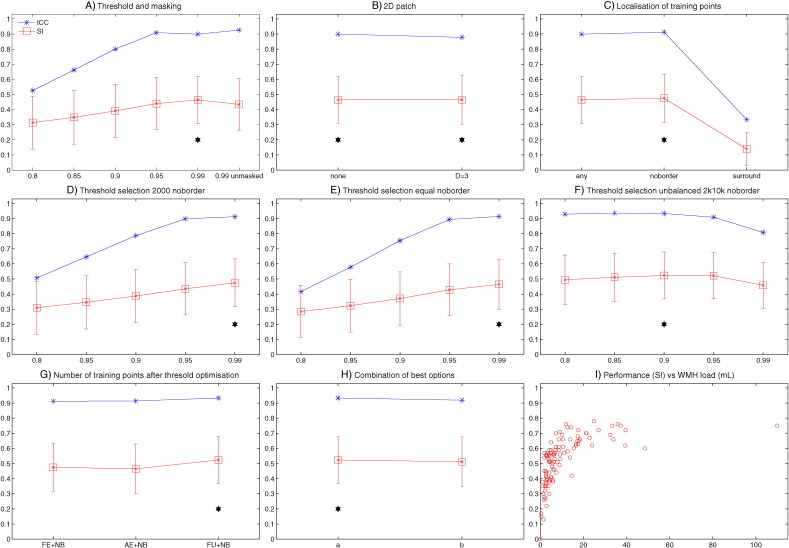
BIANCA optimisation on Dataset 2. The plots show the values of the main metrics used to evaluate BIANCA performance using different values (x axis) for the different options (panels A-H. Please refer to the main text and supplementary Table S3 for details about the options). The similarity index (SI) is shown in red, with mean value (square marker) and standard deviation (error bars) across subjects. The intra class correlation coefficient (ICC) between the total WMH volume from BIANCA output and manual segmentation is shown in blue. The black stars indicate the value(s) chosen for a specific option. Panel I shows BIANCA performance (SI) for each subject against the WMH load (WMH volume in mL extracted from the manual masks.Legend: FE = Fixed Equal, AE = All Equal, FU = Fixed Unbalanced number of training points; NB = no border. Panel H legend: a = high WMH load training subjects, FU training points, no patch, no border location for non-WMH training points, mask applied, threshold 0.9; b = high WMH load training subjects, FU training points, 2D patch D = 3, no border location for non-WMH training points, mask applied, threshold 0.9.